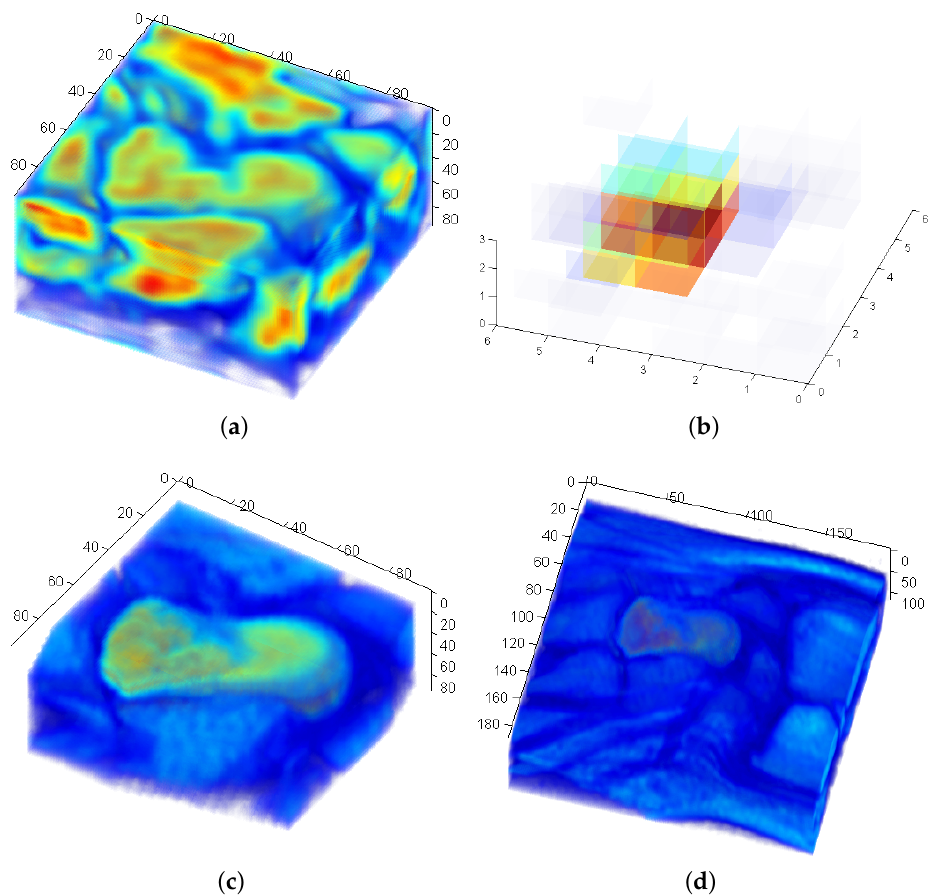
Figure 7. Registration within a large tissue region. The entire region is divided into subframes ( a ). ( b ) shows the resulting grid of S / N values (17). ( c ) shows the overlay of the correct registration result for the subframe in ( a ). ( a ) Example of one subframe within the search region—B1 is centered in this subframe resulting in a maximum visible in ( b ). ( b ) Example maxima of the search region with their corresponding divided frames. Bone B1. ( c ) Registration result within the subframe shown in ( a ). ( d ) Overlay of the re-transformed reference within the full scan region according to the correct registration result. The region and the correct position of B1 is clearly